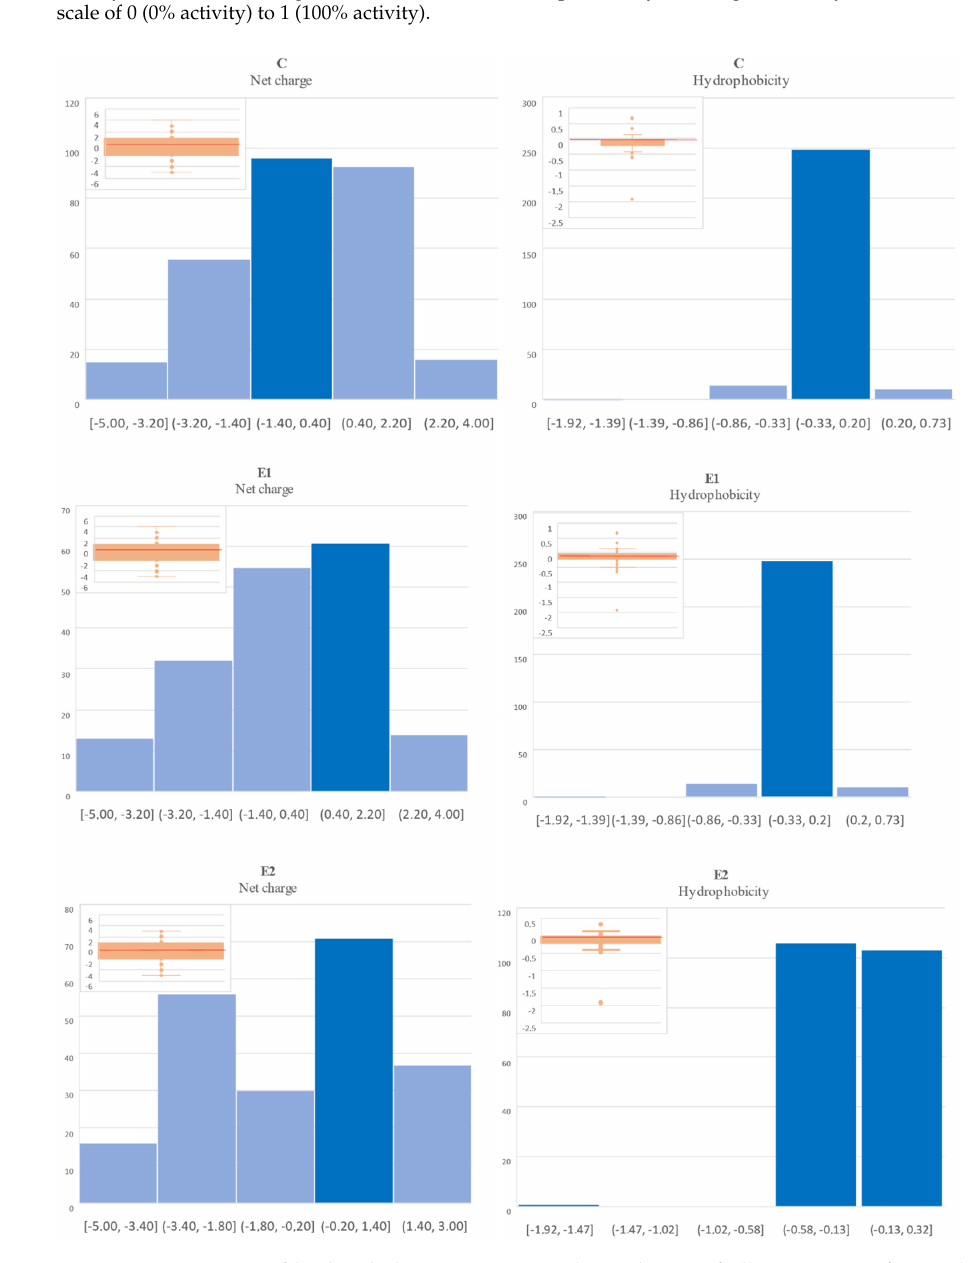
Figure 2. Summary of hydrophobic properties and net charge of all sequences of peptides with potentially anticancer activity derived from canned pork after 6 months of refrigerated storage (the y-axis shows the number of peptides with characteristic net charge or hydrophobicity values, whose specific ranges are represented by the x-axis in the above